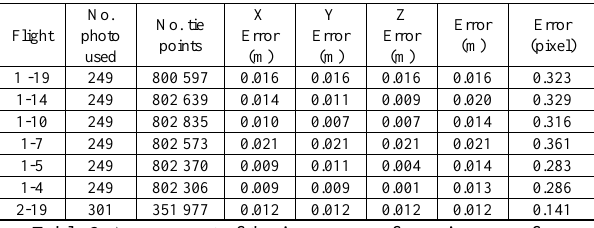
Table 2. Assessment of the image georeferencing error from ground control points